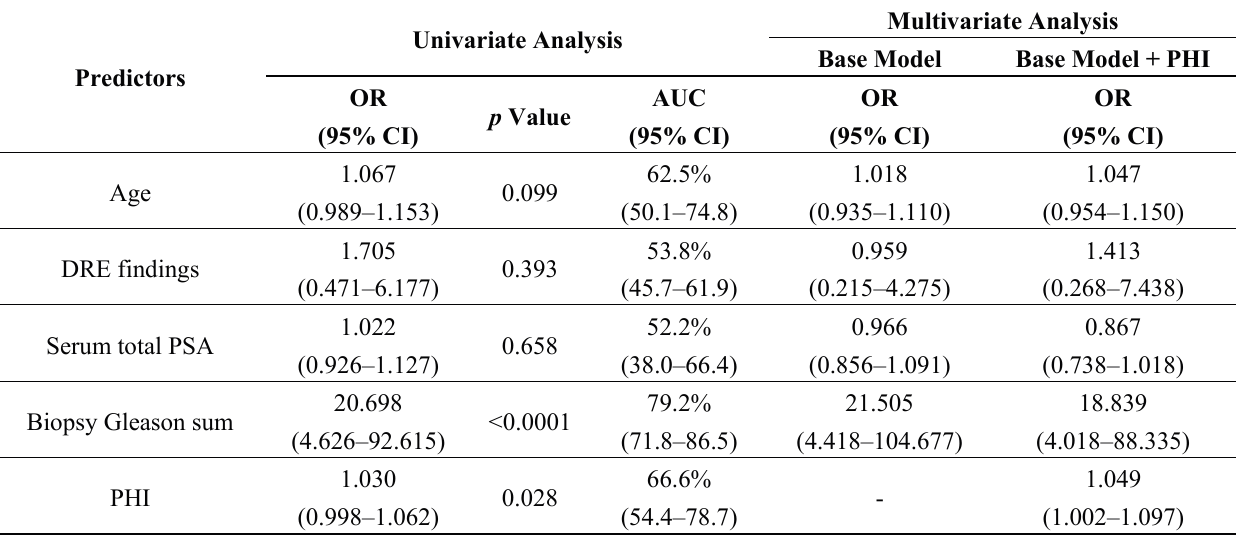
Table 4. Prediction of Gleason sum ≥ 7 at